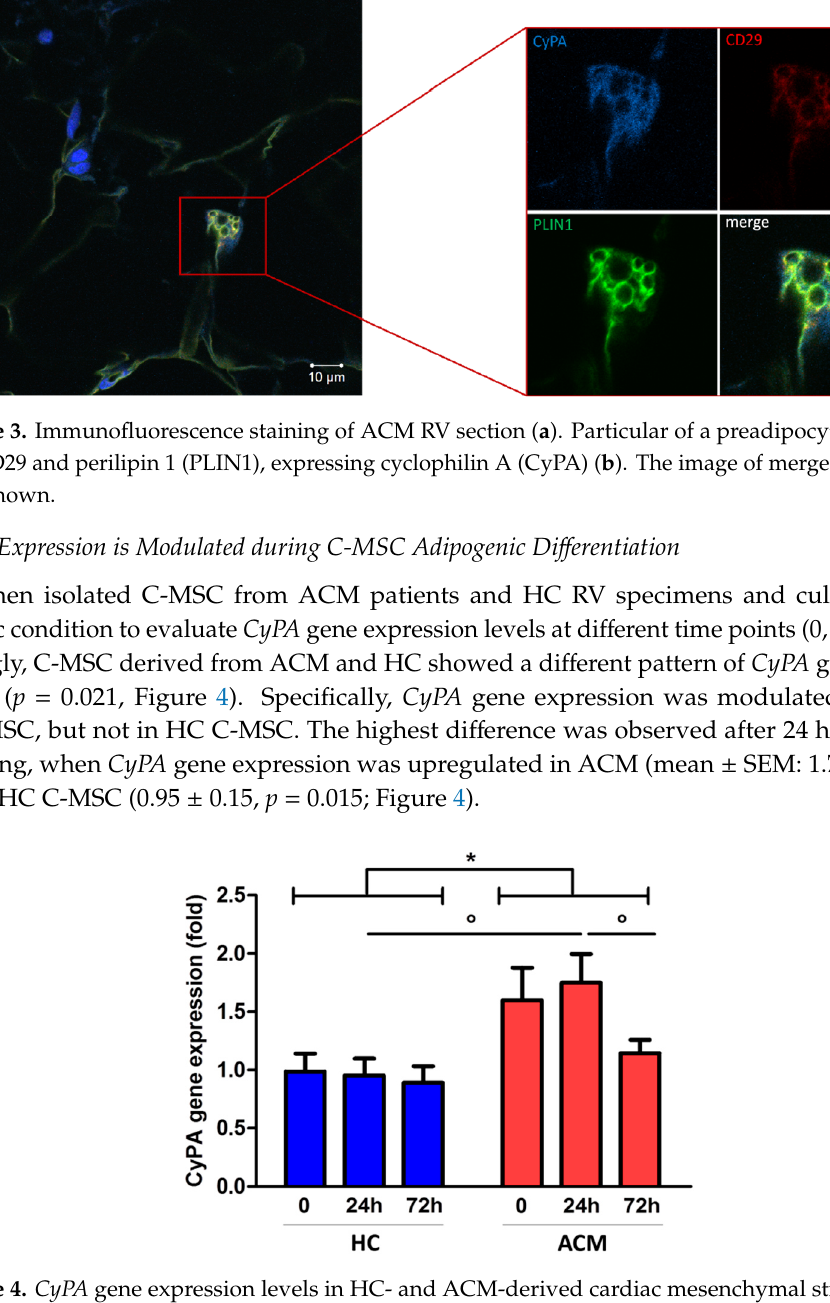
Figure 4. CyPA gene expression levels in HC- and ACM-derived cardiac mesenchymal stromal cells (C-MSC) cultured in adipogenic condition. * p value ≤ 0.05 at two-way ANOVA and ° p value ≤ 0.05 at Bonferroni post-test.